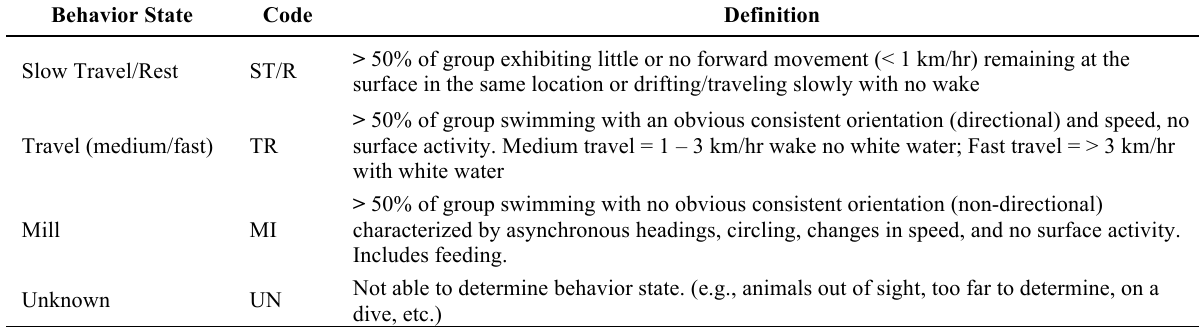
Definition of Behavioral